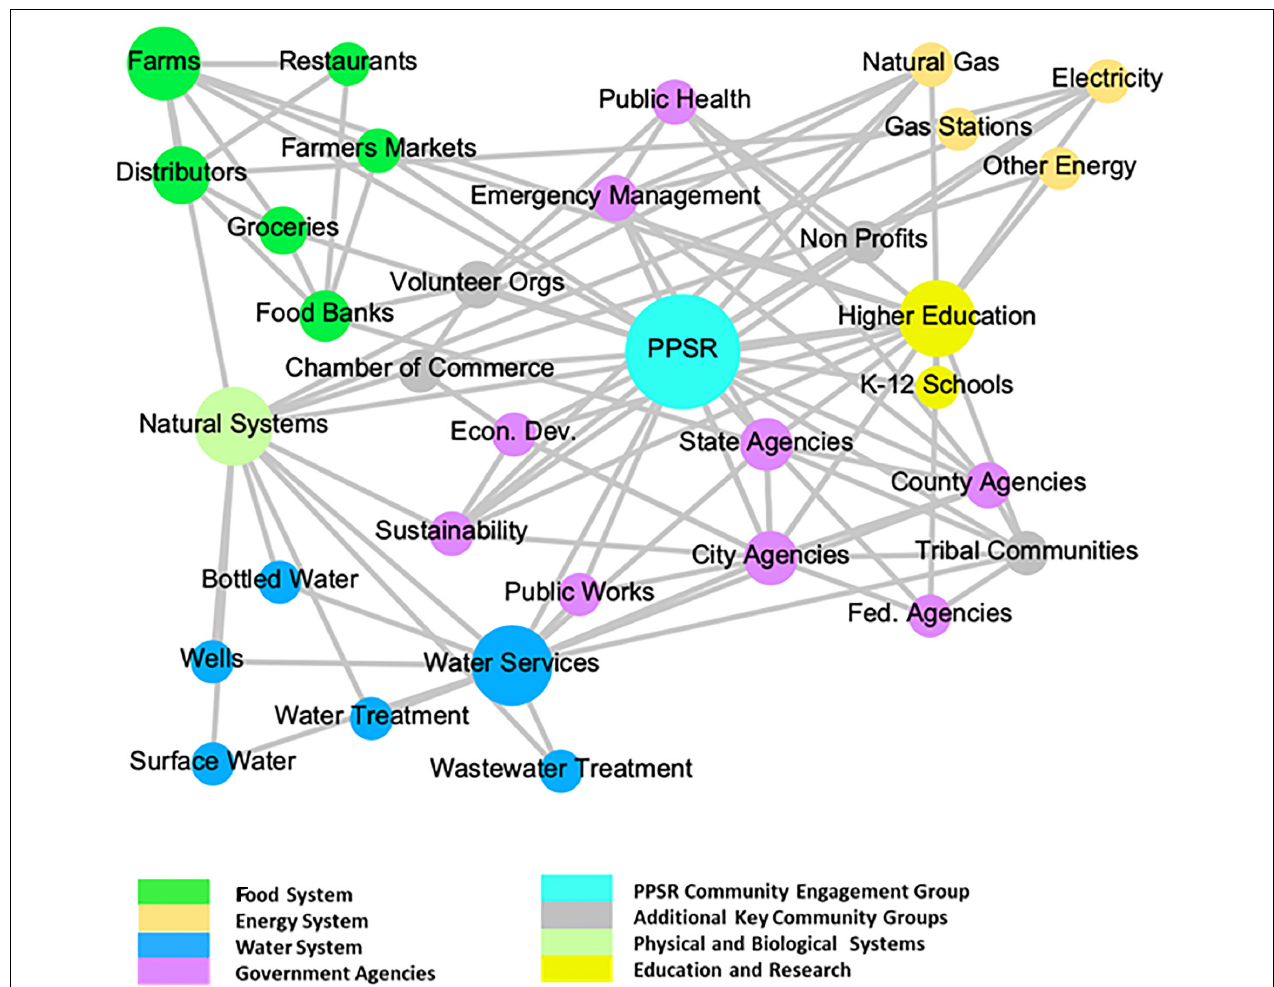
FIGURE 1 | Citizens building a network for community resilience around FEW. This figures shows stakeholder groups engaged in a pilot community in the Southwest US. Citizen volunteers and project coordinators worked with stakeholders to develop tools, content, and identify key contacts and potential community applications.